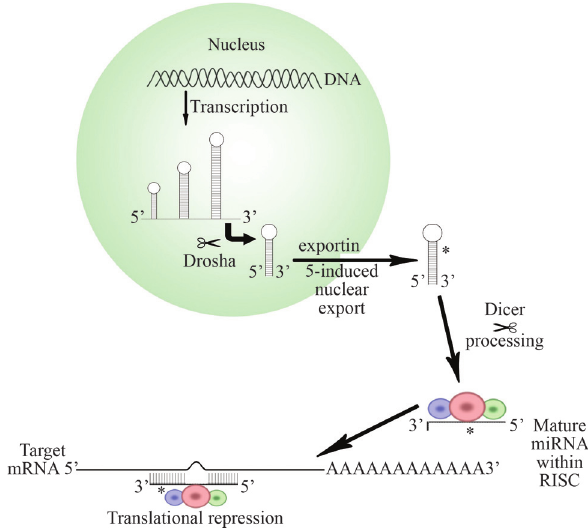
Figure 1 - The biogenesis and function of